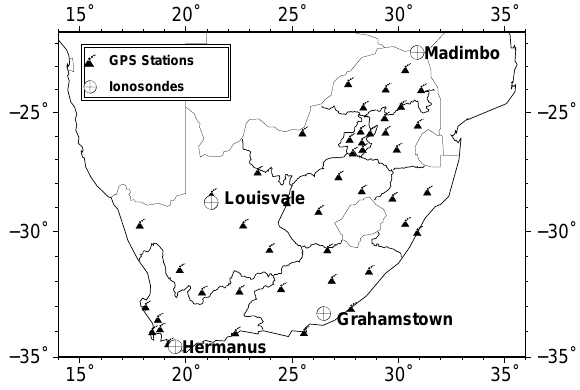
Fig. 1. CDSM GPS network and the four ionosondes are indicated. Note the co-located GPS receivers at Grahamstown, Louisvale and Hermanus ionospheric stations.